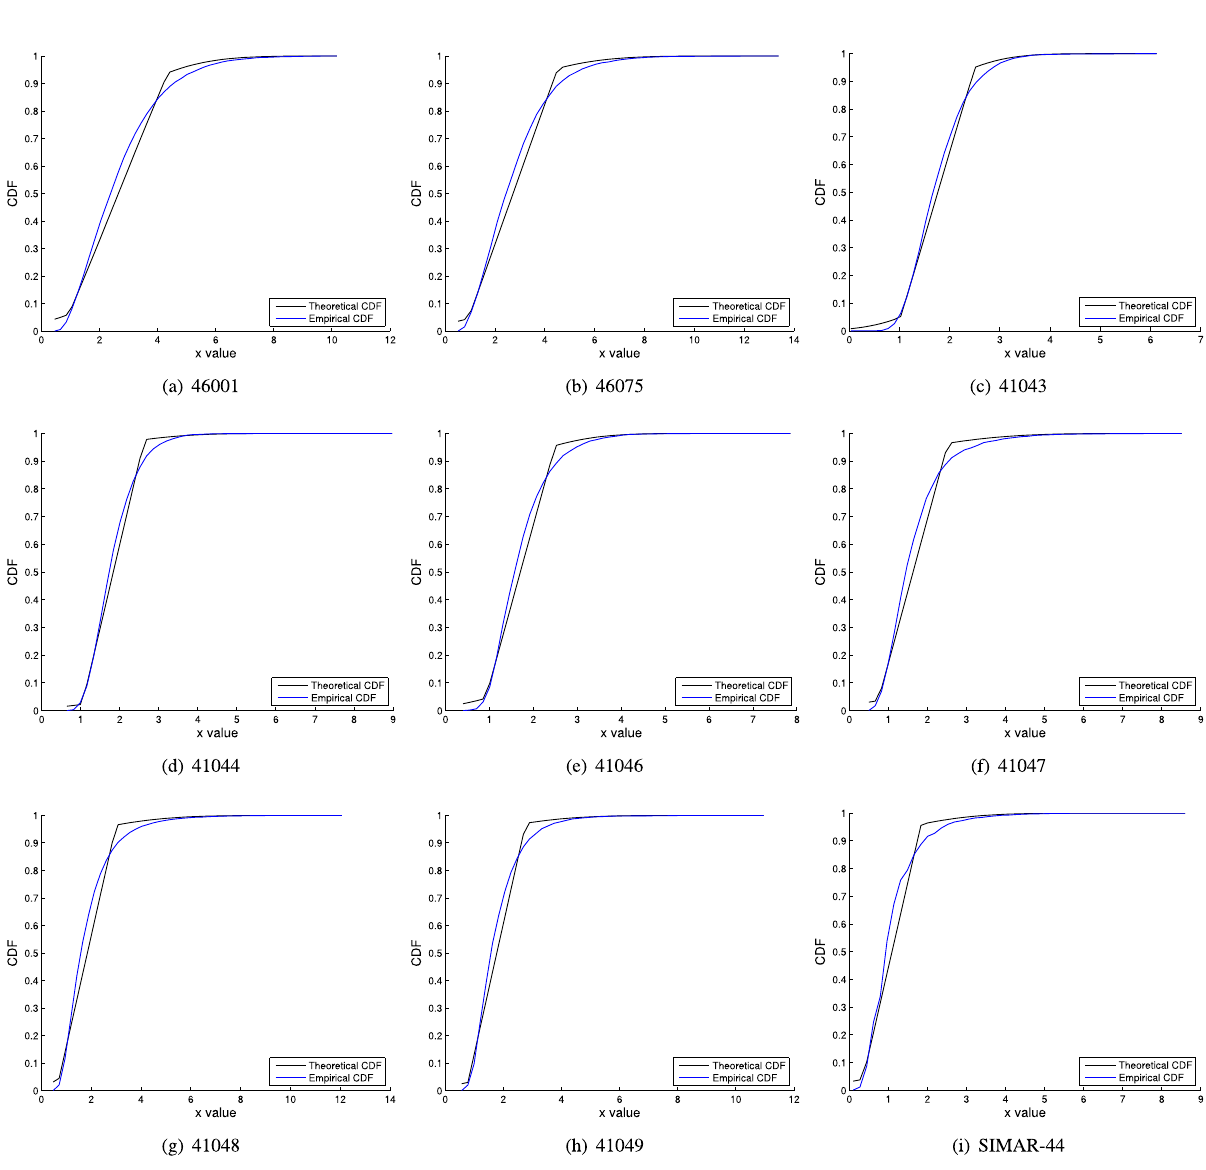
Figure 3. Estimated theoretical distribution versus empirical distribution in all wave height time series